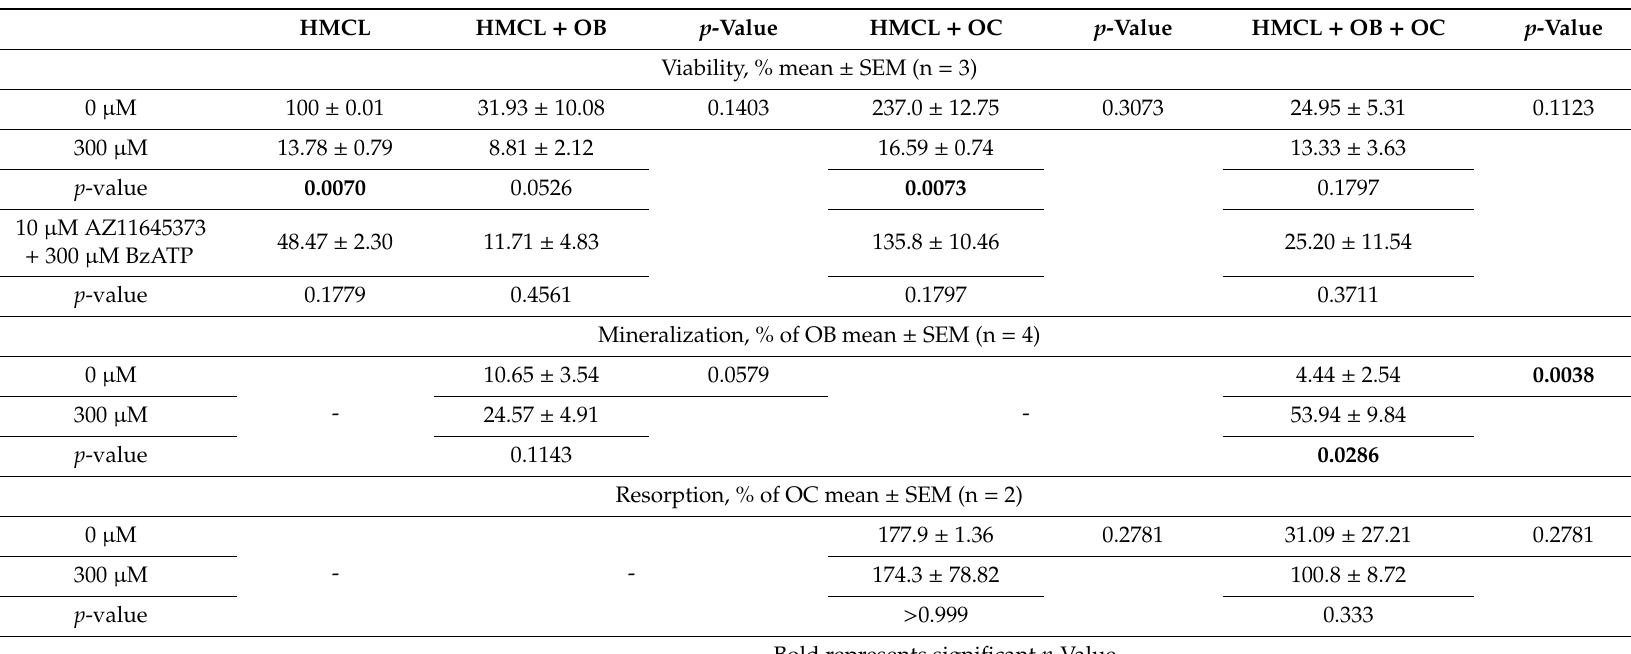
Table 2. E ff ect of P2X7 receptor activation of RPMI-8266 interaction with osteoblasts and osteoclasts in 3-cell culture set up in